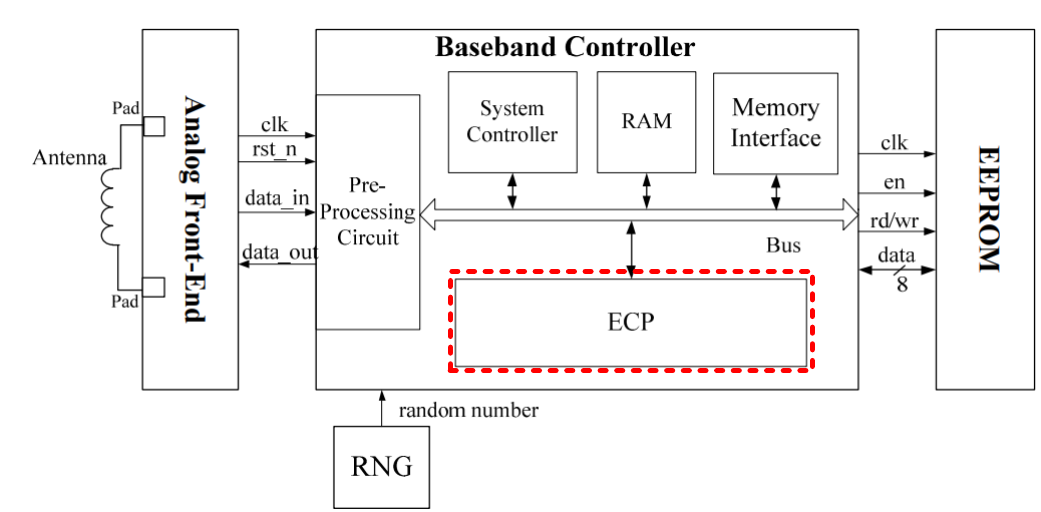
Figure 1. Structure of an RFID tag chip with Elliptic-curve Cryptography Processor (taken from [11]). We provided our architecture for the ECP block highlighted with red color dotted